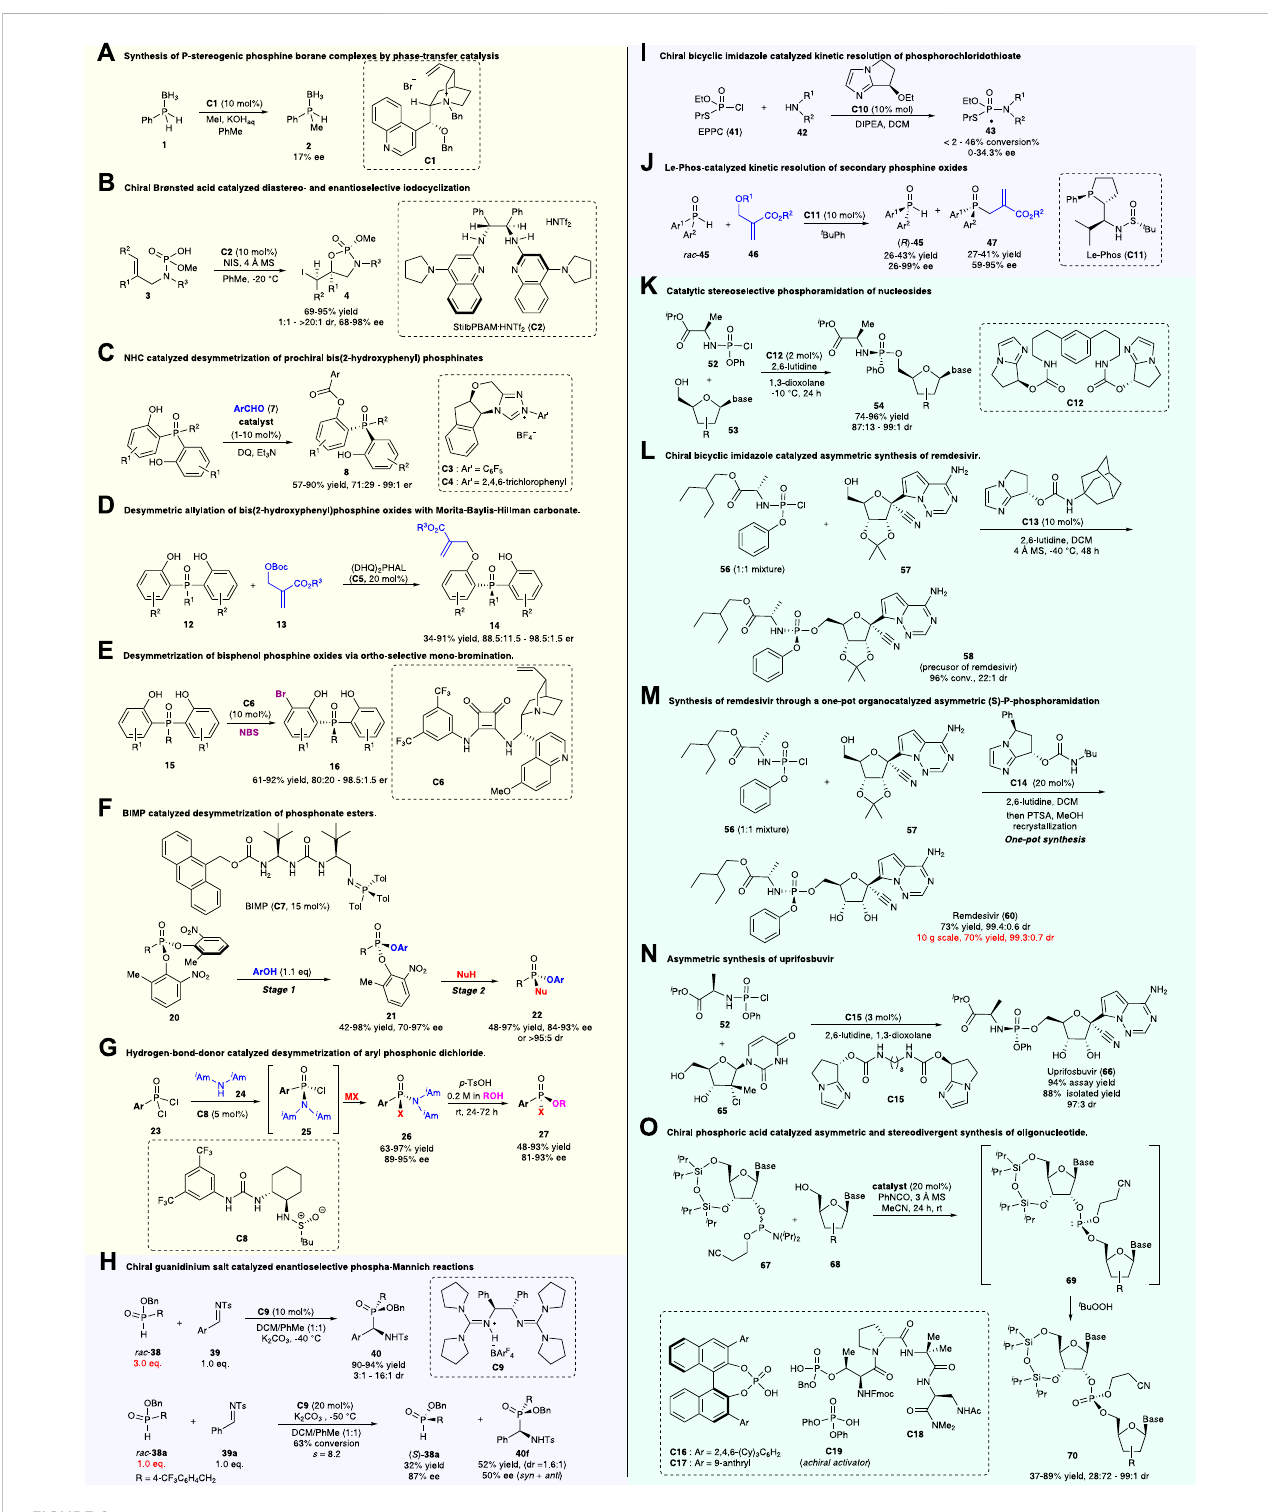
FIGURE 2 Organocatalytic asymmetric strategies for access to P-stereogenic compounds. (A – G) : Desymmetrization strategies; (H – J) : Kinetic resolution; (K – O) : Dynamic kinetic resolution strategies.